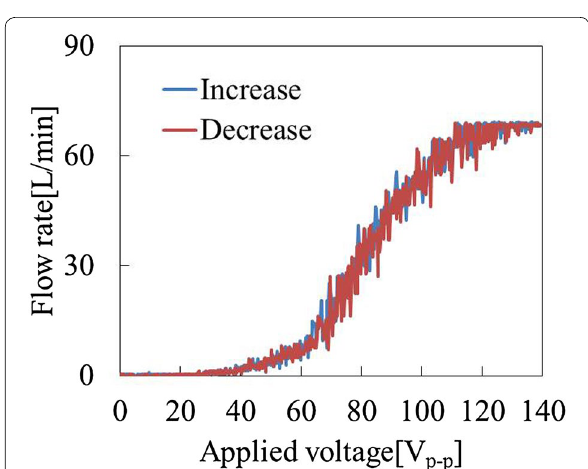
Fig. 18 Hysteresis of flow control